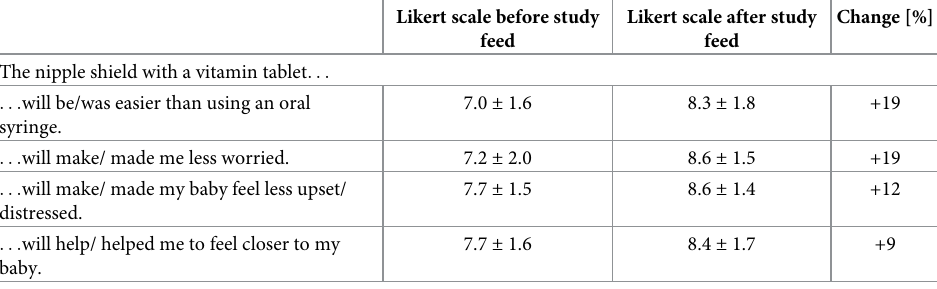
Likert scale before study Likert scale after study Change [%] feed feed